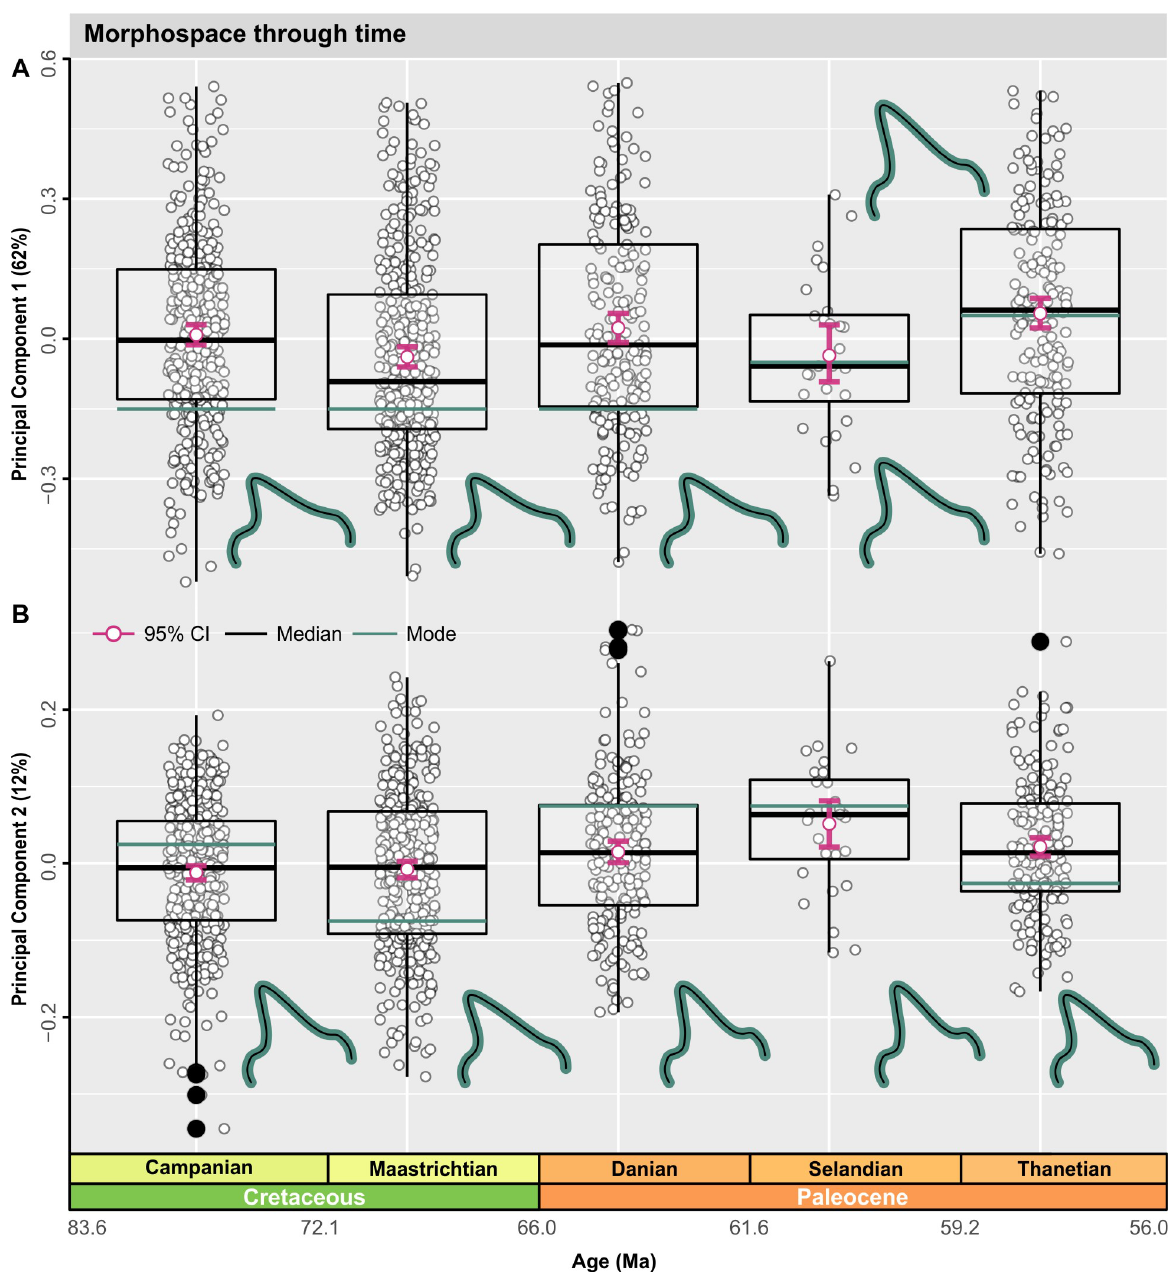
Fig 7. Global morphospace time series. (A, B) Jittered box plots visualizing the distribution of time-bins along PC1 and PC2. Graph depicts patterns of overall shape change using the 5-age time-binning scheme. Measures of central tendency, including the median (black line) and arithmetic mean (pink), are shown with computed 95% nonparametric bootstrap confidence intervals and potential outliers (closed black points). TPS grids indicate changes in modal value (green line) between time-bins. The data used in this analysis can be accessed online at